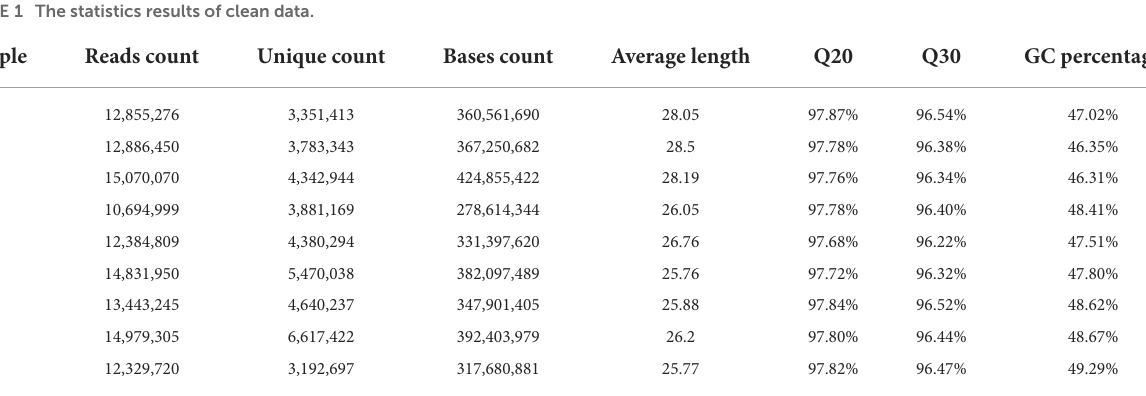
TABLE 1 The statistics results of clean